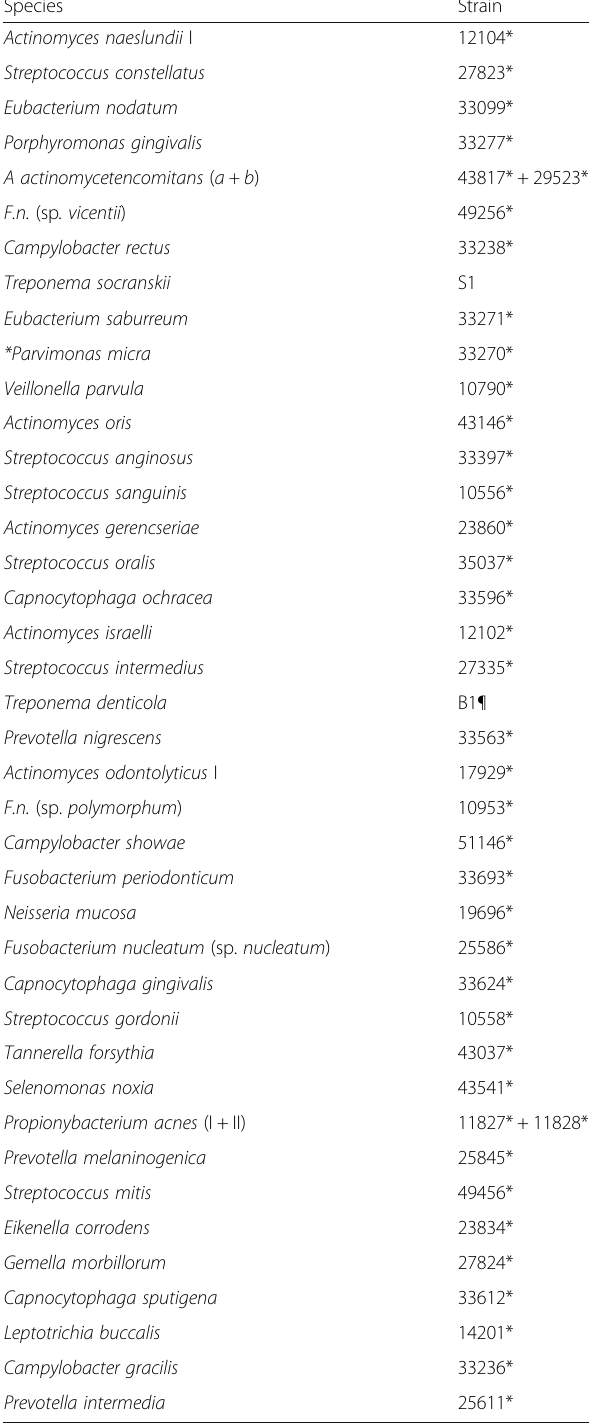
Table 1 Bacterial species strains used on checkerboard DNA- DNA hybridization